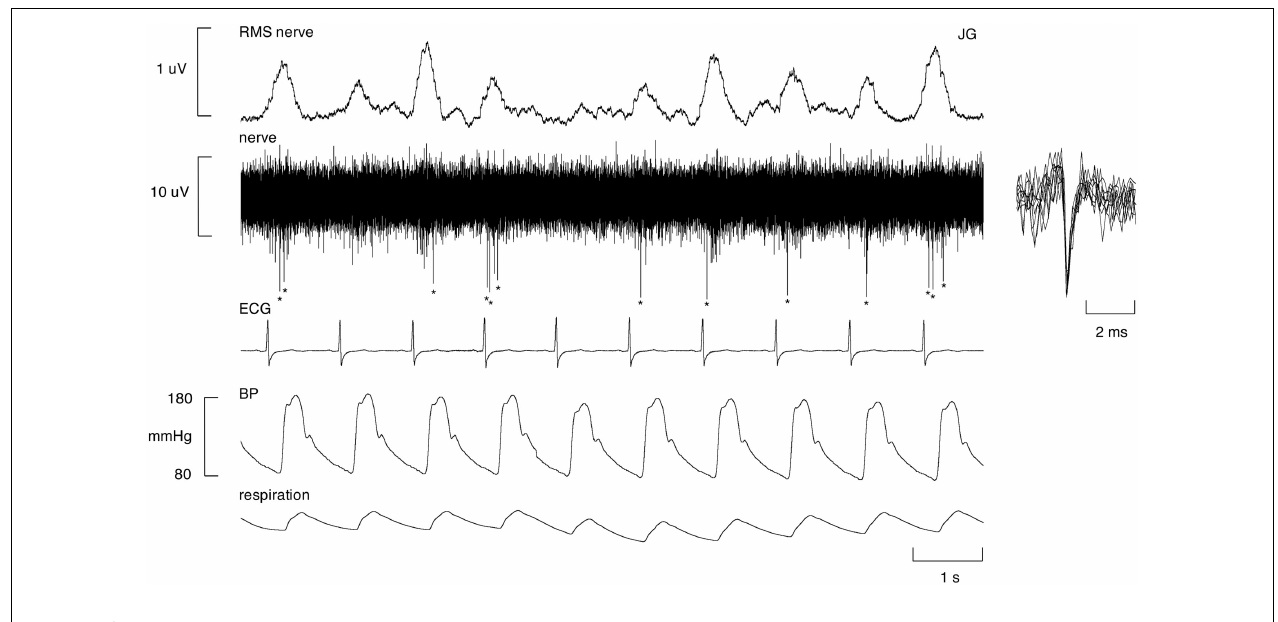
FIGURE 1 | Unitary recording from a single muscle vasoconstrictor neuron in an awake female patient with COPD. This unit generally fired only one spike (indicated by asterisks) per cardiac interval, but occasionally fired multiple spikes within a burst of MSNA. Superimposed